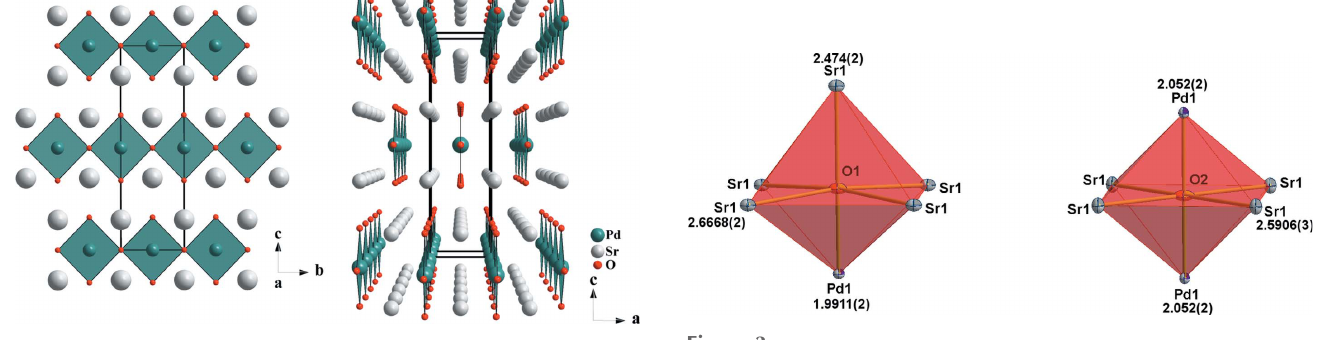
Figure 1 Crystal structure of Sr 2 PdO 3 viewed along the a axis (left) and along the b axis